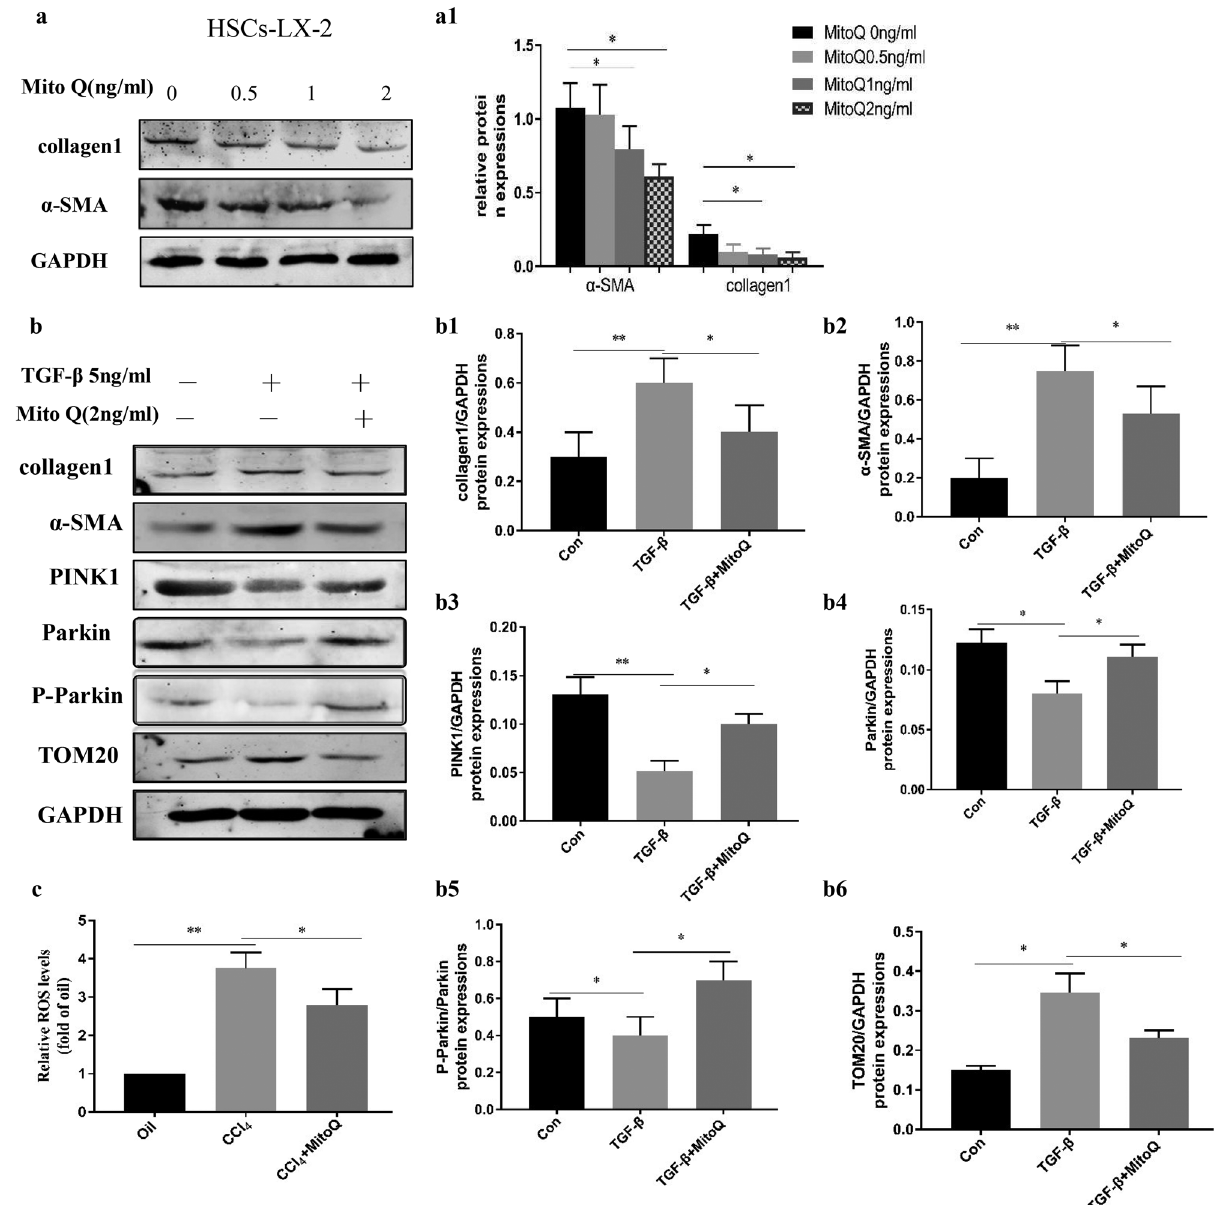
Figure 3: Mitophagy decreases with the LX - 2 activation, and MitoQ enhances mitophagy and reduces ROS levels. ( a ) TGB - β to activate the LX - 2 in vitro , Western blot analysis showing collagen 1 and α - SMA expression in LX - 2 cells treated with di ff erent concentrations of MitoQ. ( a1 ) Columns represent the gray - scale value of α - SMA and collagen 1 expression. Data show the mean ± standard deviation. Experiments were repeated three times. * P < 0.05. ( b ) Western blot analysis showing collagen 1, α - SMA, PINK1, parkin, P - parkin, and TOM20 expression with TGF - β stimulation and MitoQ intervention in LX - 2 cells. ( b1 ) Columns represent the gray - scale value of collagen 1 expression. ( b2 ) Columns represent the gray - scale value of the α - SMA expression. ( b3 ) Columns represent the gray - scale value of the PINK1 expression. ( b4 ) Columns represent the gray - scale value of parkin expression. ( b5 ) Columns represent the gray - scale value of P - parkin expression. ( b6 ) Columns represent the gray - scale value of TOM20 expression. Data show the mean ± standard deviation. Experiments were repeated three times. * P < 0.05, and ** P < 0.01. ( c ) ROS probe was used to detect the levels of ROS in LX - 2 cells, * P < 0.05, and ** P <